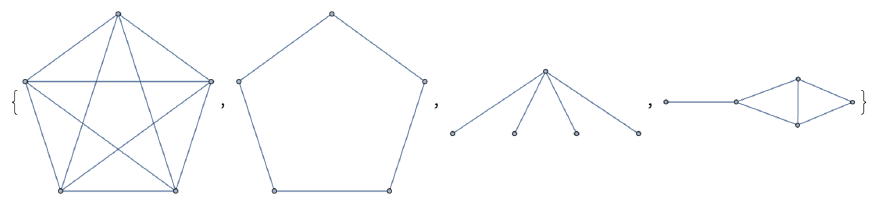
Figure 5. Graph representation of Q [2]